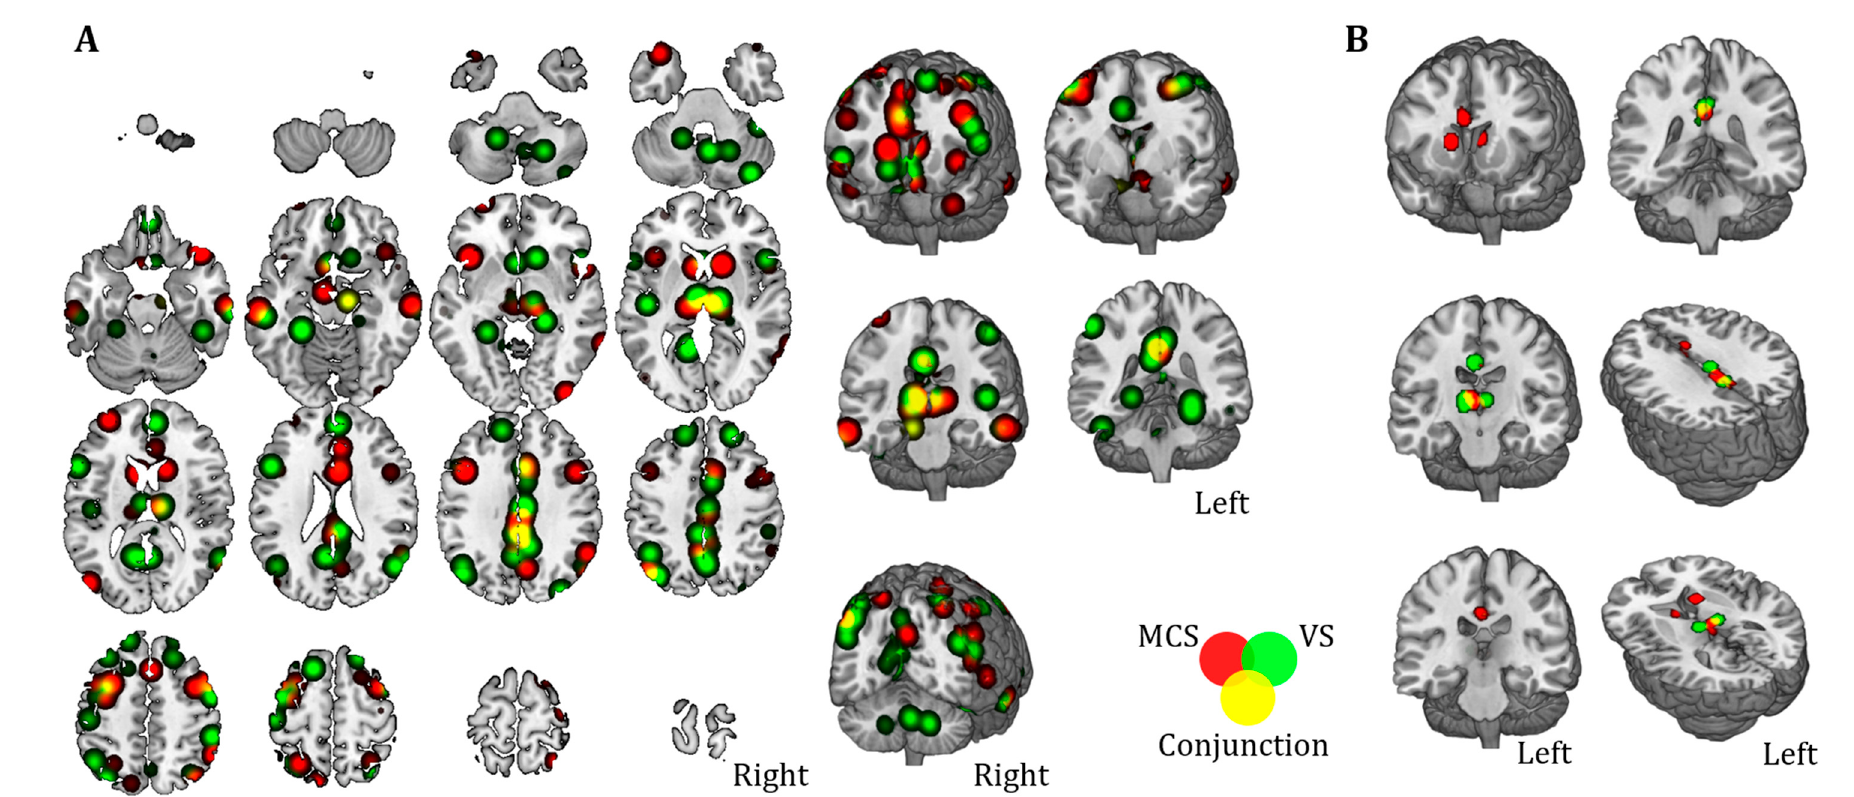
Figure 3. Similarities and differences between MCS (Minimally Conscious State) and VS. Brain hypoactivation during resting-state is shown for MCS (red) and VS patients (green), as well as for overlapping regions (yellow). The map shows the qualitative overlap without any statistical threshold (panel A), as well as with a family-wise error (FWE) correction both at the cluster level and voxel level ( p < 0.001 for cluster-formation; p < 0.05 for cluster-level inference, panel B).